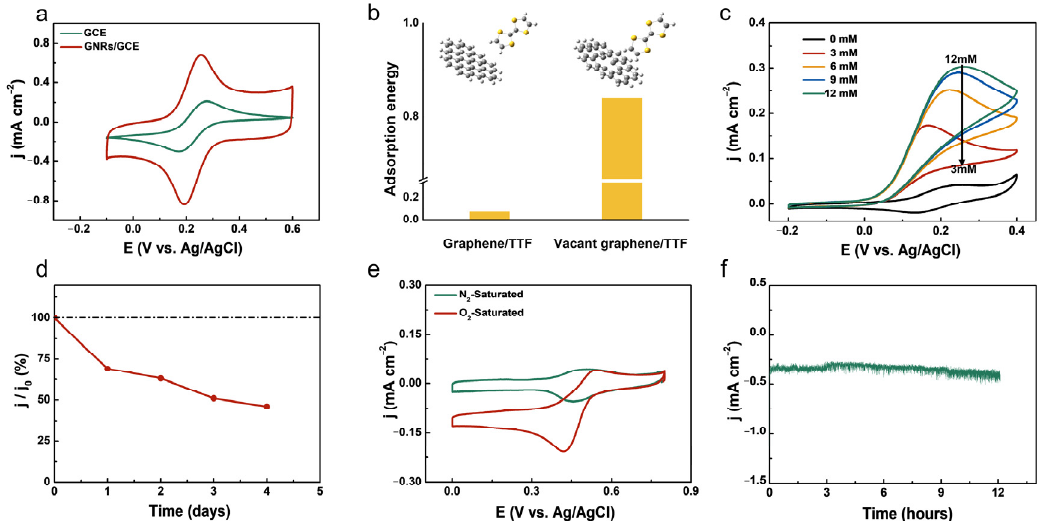
Figure 3. ( a ) CVs curve of GCE and GNRs/GCE in 0.1 M KCl containing 5 mM [Fe (CN) 6 ] 3 − /4 − . ( b )